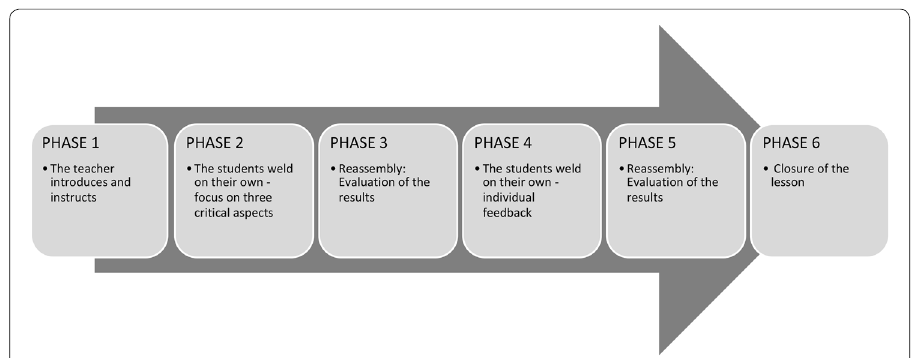
Fig. 2 Process of the lessons cycle 1 and cycle 2